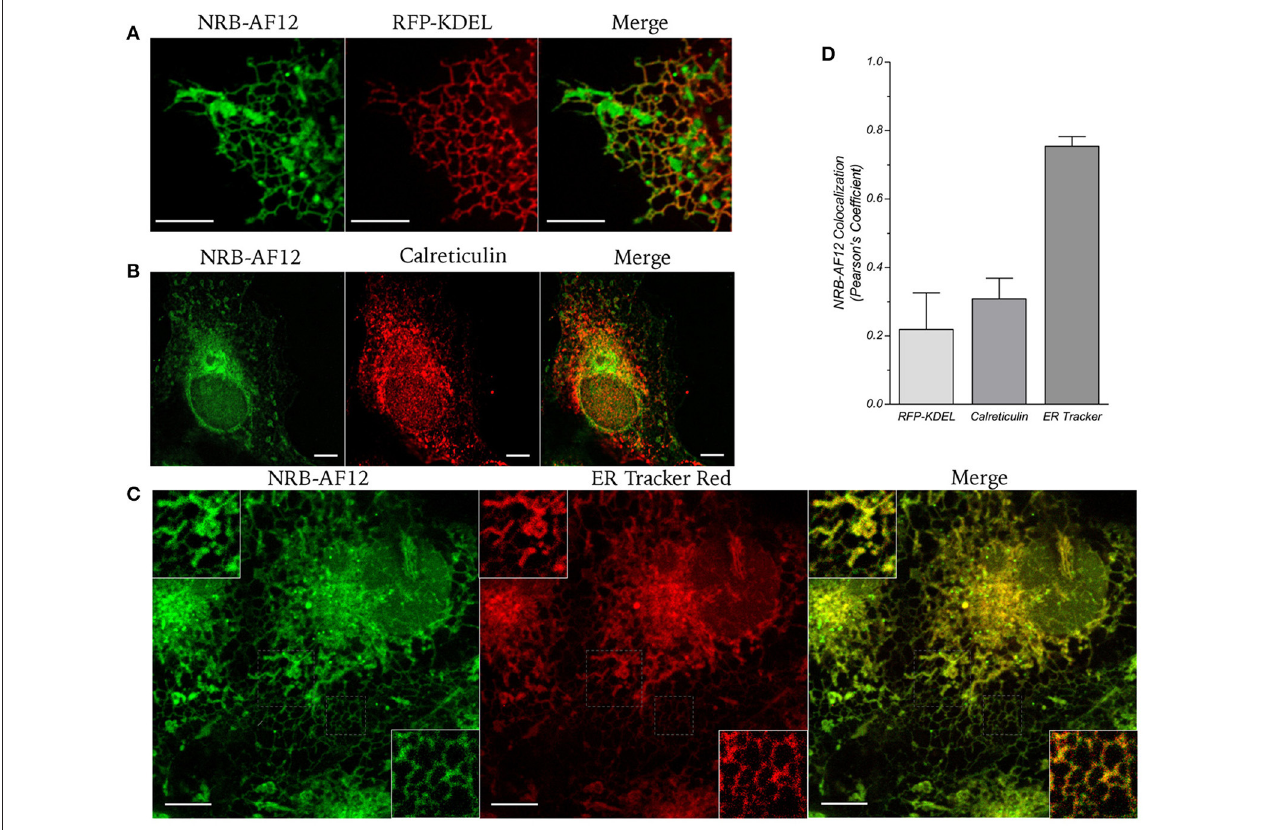
FIGURE 2 | (A) Live cell imaging of LX2 cells transfected with ER-reporter RFP-KDEL plasmid and subsequently stained with NRB-AF12. (B) Immunostaining of LX2 cells for the endoplasmic reticulum marker calreticulin; cells were counter-labeled with NRB-AF12. (C) Confocal live cell imaging of LX2 cells fluorescently labeled with 500 η M NRB-AF12 and 500 η M ER-Tr red. Insets show magnification of the pictures. Magnification 60x; scale bar 10 µ m. (D) Quantification of NRB-AF12 co-localization with RFP-KDEL, Calreticulin and ER-Tr is shown as Pearson’s coefficient. ( n ≥ 10).